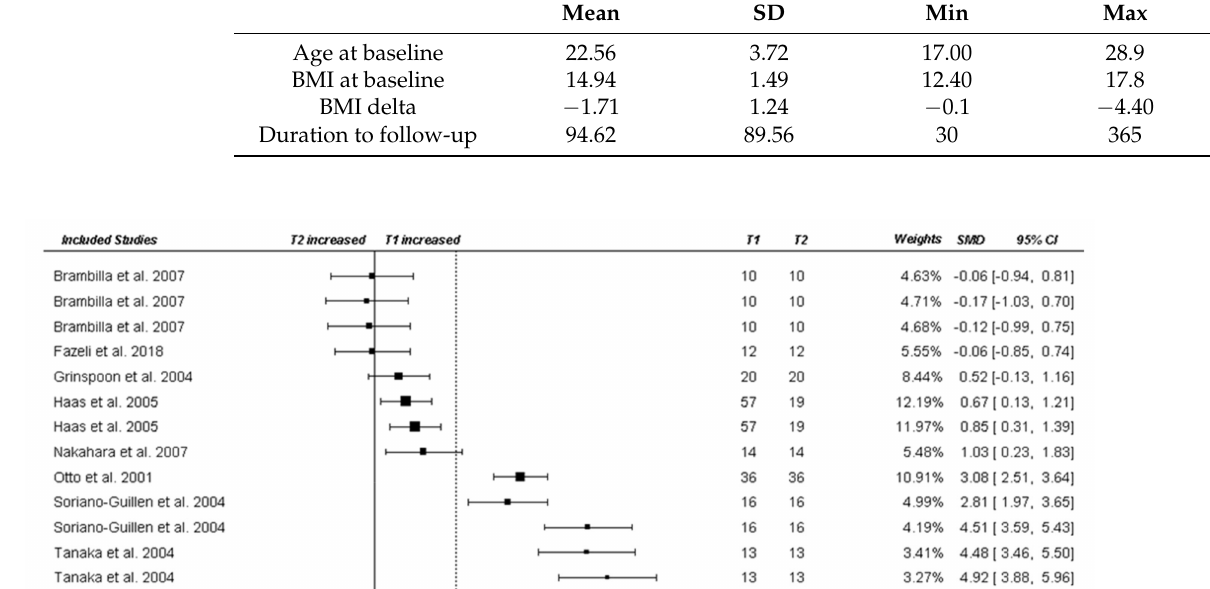
Figure 2. Forest plot of cross-sectional comparison of AN patients at baseline (pre-treatment; T1) and HCs on total ghrelin. AN = anorexia nervosa; HC = healthy control; SMD = standardized mean difference, CI = confidence interval. Studies listed more than once reported separate values for AN subtypes. Figure 5. Forest plot of longitudinal comparison of acute AN patients at baseline (T1) and follow-up (T2) on total ghrelin. Studies shown more than once had more than one follow-up occasion. T1 = at baseline (pre-treatment); T2 = at follow-up. SMD = Standardized change score baseline—follow-up, CI = confidence interval. Table 2. Meta-regression for longitudinal changes in total ghrelin from baseline (T1) to